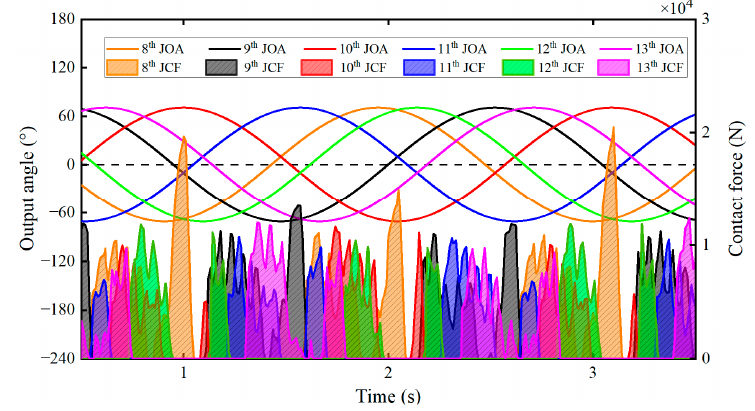
Figure 18. The output angle and contact force of six adjacent joints.